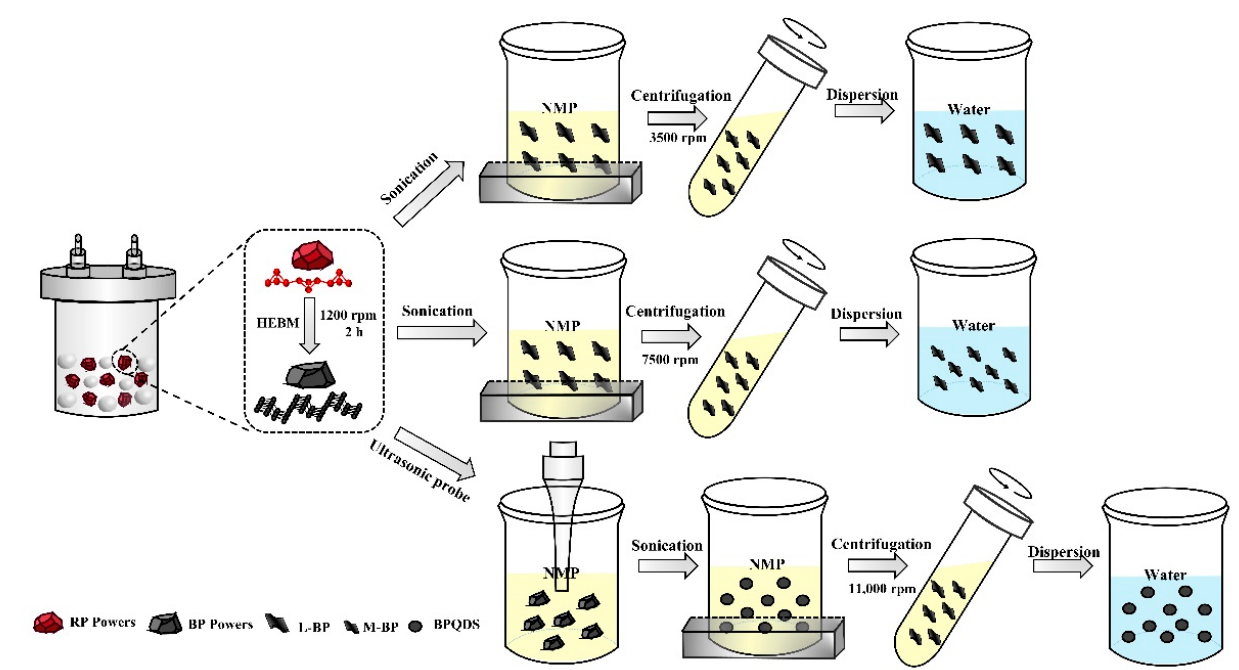
Figure 1. Synthesis process of different-sized BP-NS as lubrication additives.